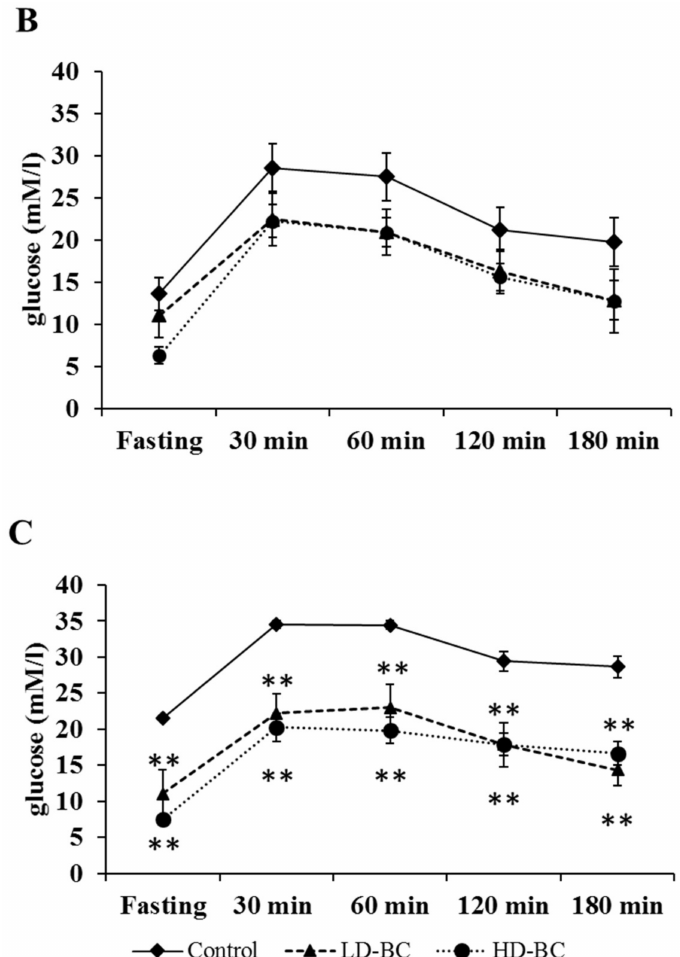
Figure 4. The effect of BC treatment on blood glucose level before ( A ), at halftime ( B ) and at the end ( C ) of the treatment period. The animals ( n = 10 animals per group), fed daily by gavage for 4 weeks with a mucin-water vehicle or BC were evaluated for their fasting serum glucose content immediately prior to oral administration of 3 g of glucose per kg of their body weight. The results are provided as an average serum glucose content, in mmol/L of peripheral blood, ± SEM. ** p < 0.005 control versus BC treated